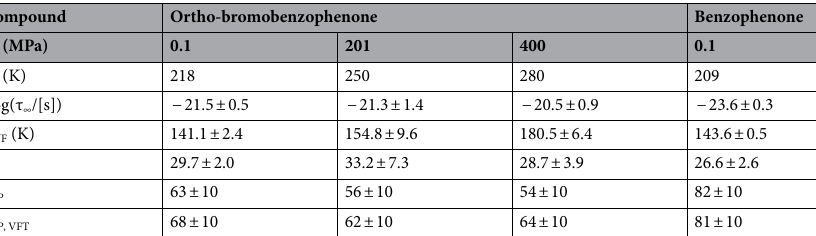
Table 1. Dynamic glass transition temperatures, VFT parameters of the primary α relaxation in the proximity of T g , and kinetic fragility index of BrBPh and BPh. The latter was computed either from a linear fit (m P ) or from the VFT parameters (m P ,VFT